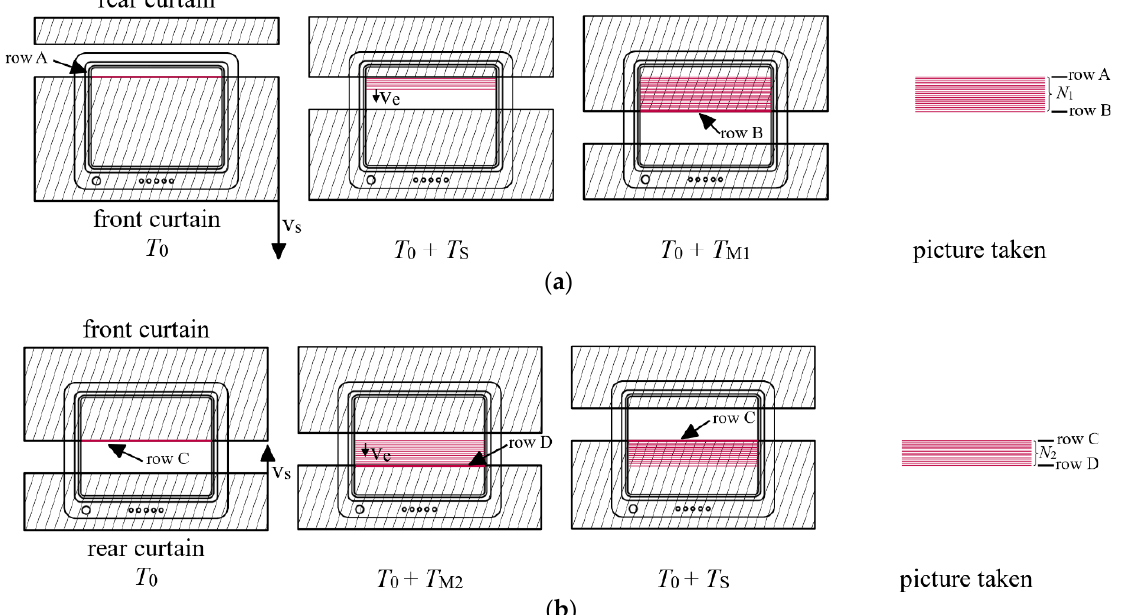
Figure 11. Exposure of a monitor screen. The refreshing of the monitor is done from top to bottom. ( a ) Inverted camera (in upside down position), curtain falling from top to bottom on the image. ( b ) Camera in normal position, curtains moving from bottom to up on the image.